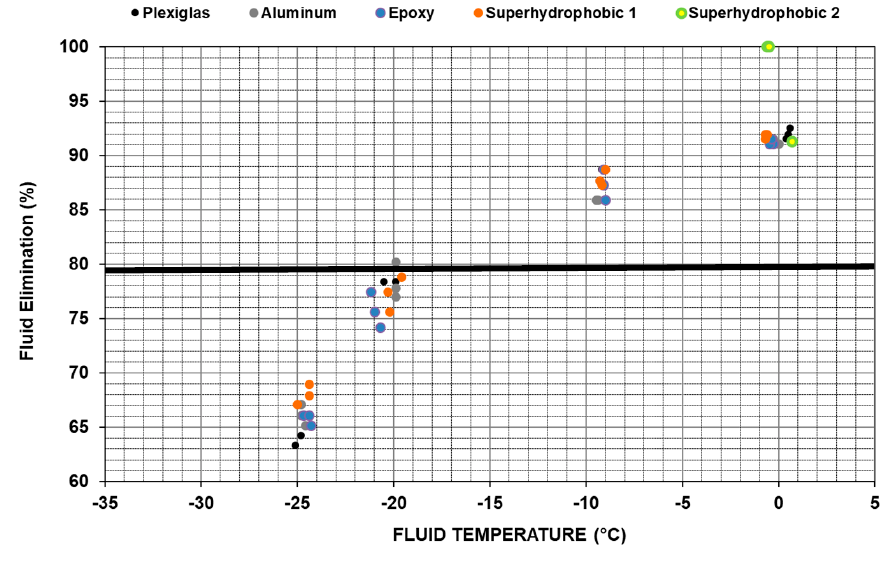
Figure 17. Fluid elimination for Ref. Fluid.